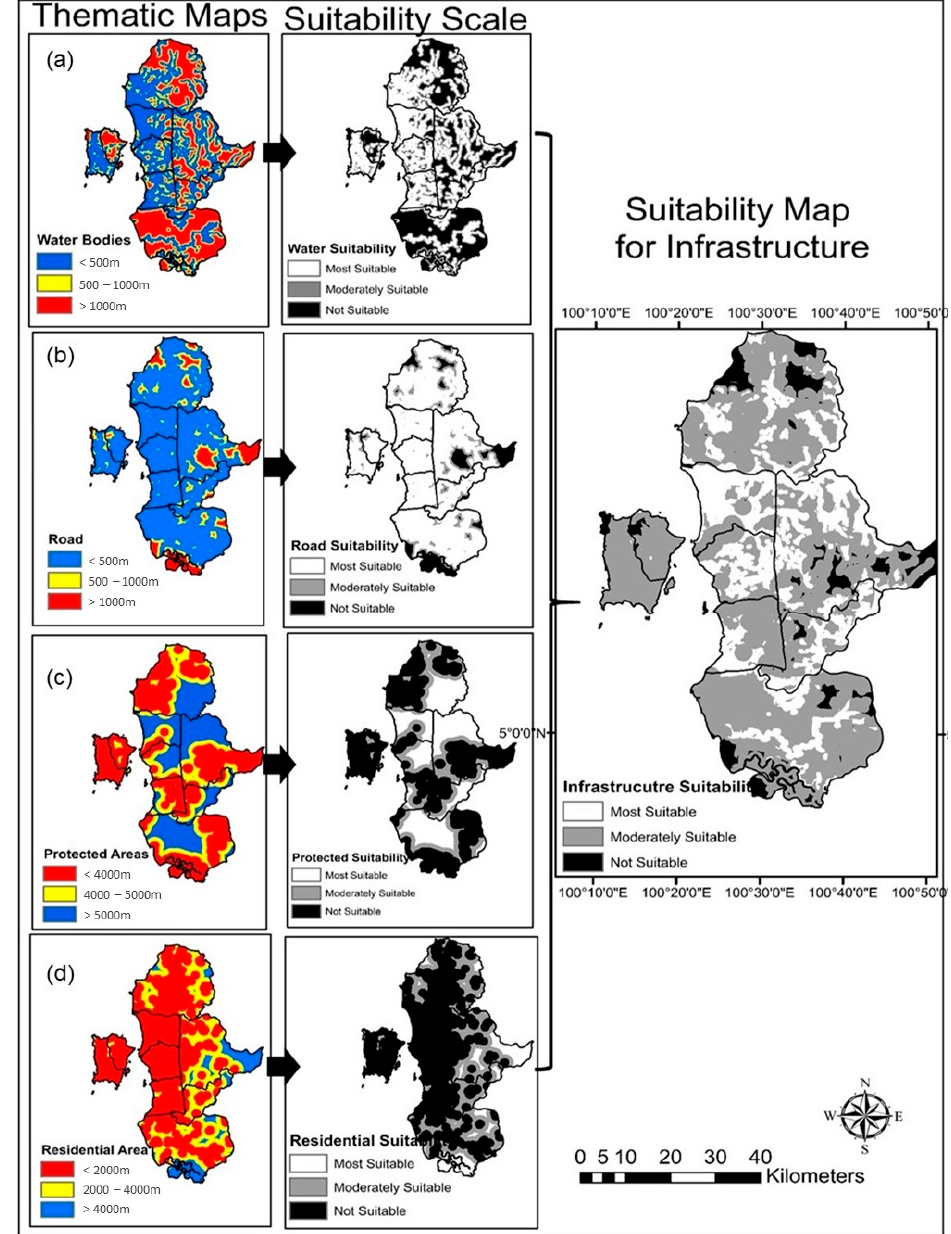
Figure 5. Process of producing infrastructure facilities suitability map from ( a ) water bodies, ( b ) road, ( c ) protected area, and ( d ) residential area.